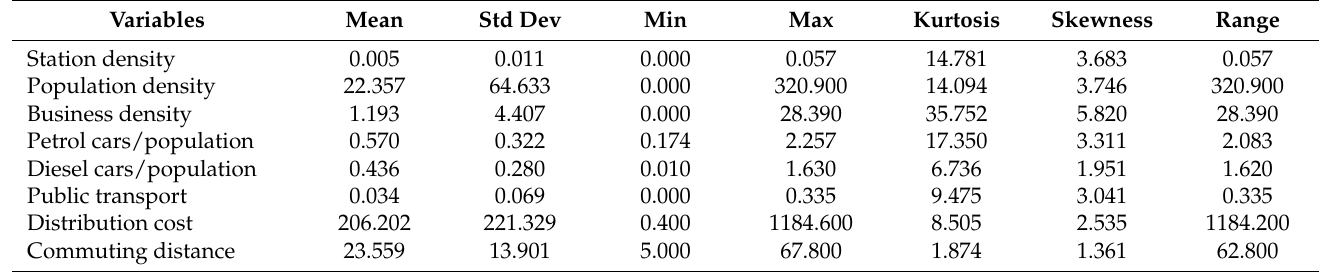
Table 2. Summary statistics of the characteristics of 44 cities in